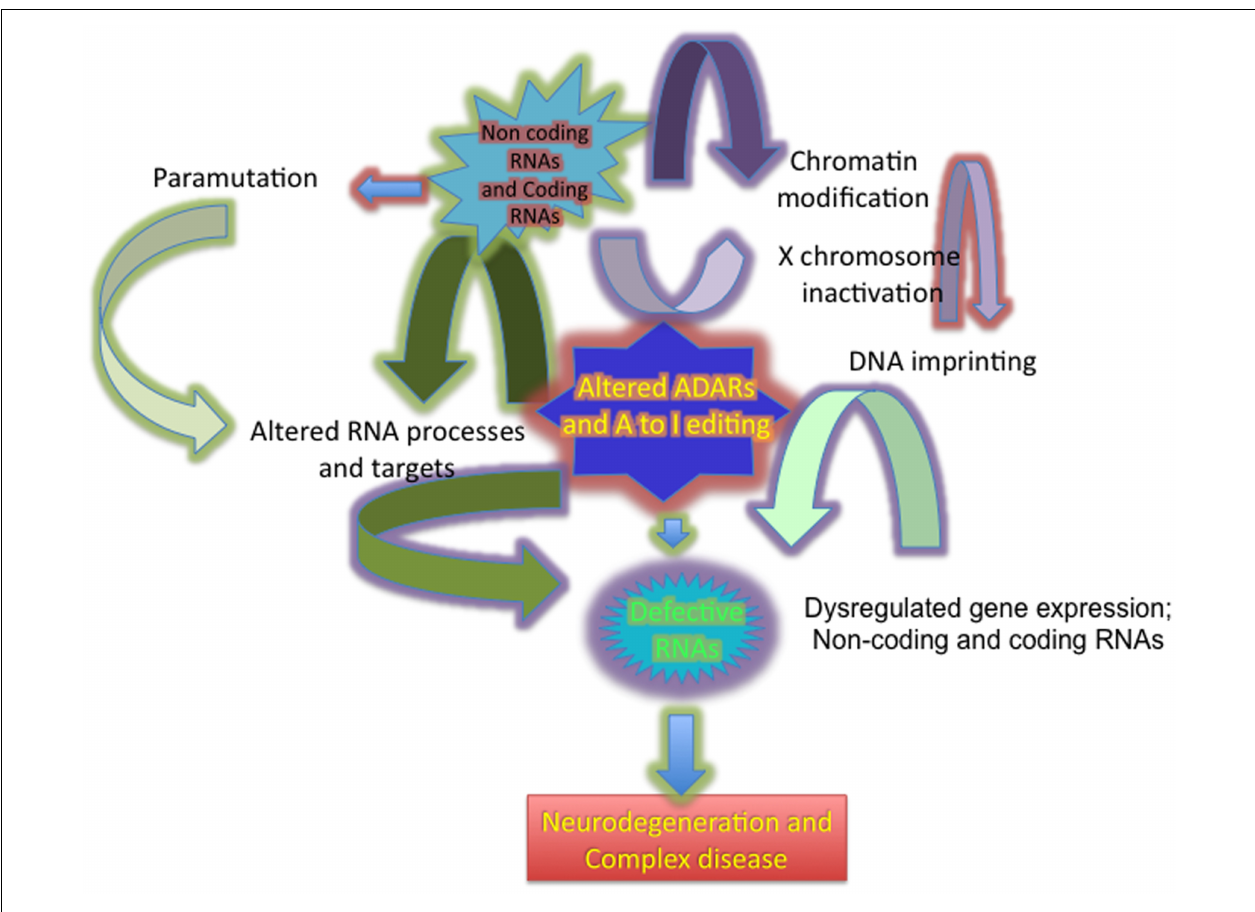
FIGURE 1 | Diagram showing the broad impact of dysregulatedADARs in alteringA to I editing, producing defective RNAs and altering gene expression in